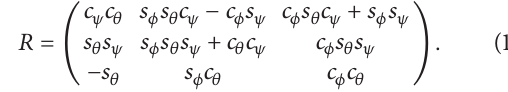
Figure 3: Quadrotor’s body-fixed and inertial coordinate systems.